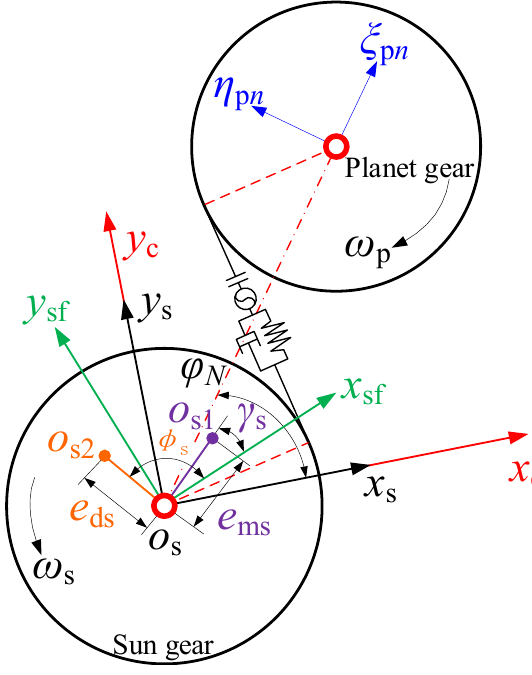
Figure 23. Manufacturing error.